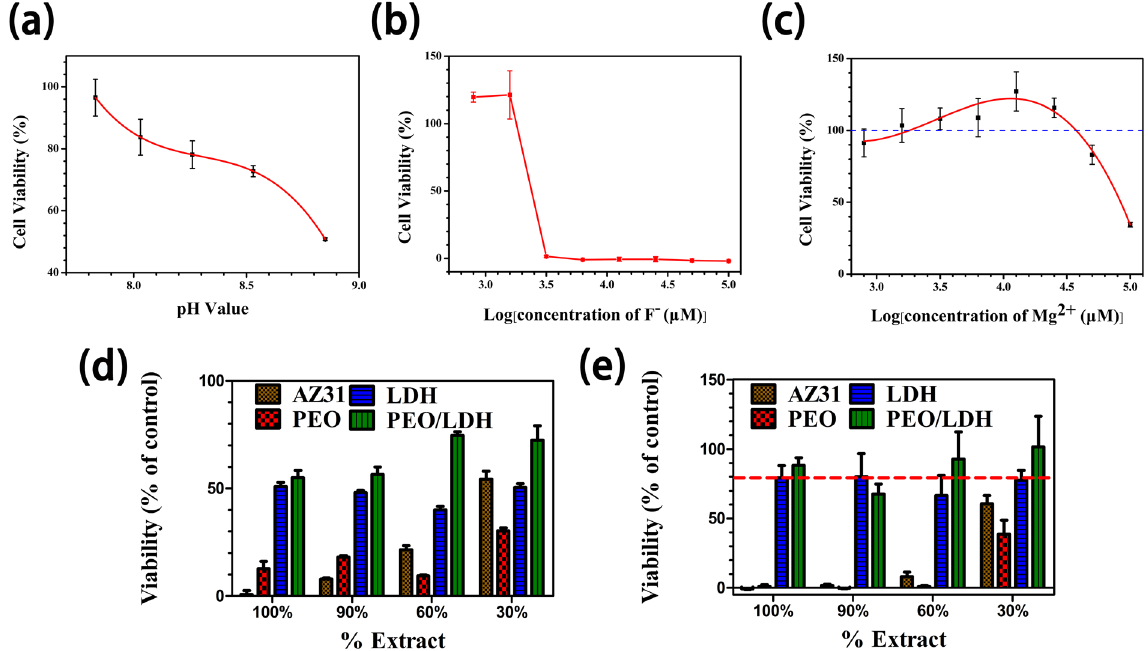
Figure 7. The influence of pH values ( a ), concentration of F ions ( b ) and Mg ions ( c ) to cell viability. Viability of cells incubated for 1 d ( d ) and 4 d ( e ) with different concentration extract of all samples.